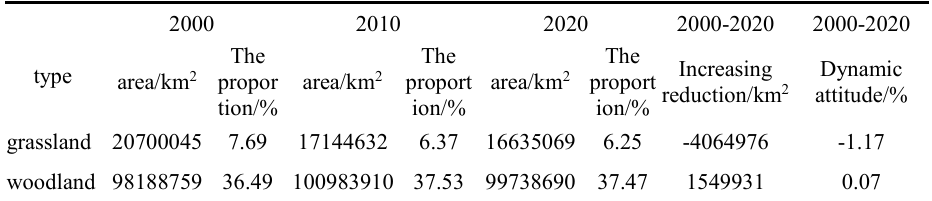
Table 1. Land use change in Chengdu-Chongqing urban agglomeration from 2000 to